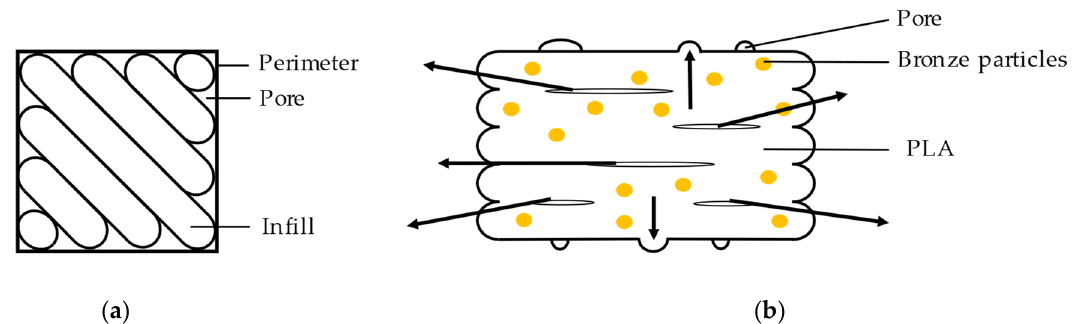
Figure 10. Illustration and scanning electron microscope (SEM) images of printed green tensile spec- imens (The red circles showed pores/gaps on the surfaces or inside of the specimens). ( a1 ) Illustra- tion of flat printed specimen; ( a2 ) top view of the flat specimen; ( a3 ) cross section of the flat speci- men; ( a4 ) zoomed view of cross section of the flat specimen; ( b1 ) illustration of on-edge printed specimen; ( b2 ) top view of the on-edge specimen; ( b3 ) cross section of the on-edge specimen; ( b4 ) zoomed view of cross section of the on-edge specimen; ( c1 ) illustration of upright printed specimen; ( c2 ) top view of the upright specimen; ( c3 ) cross section of the upright specimen; ( c4 ) zoomed view of cross section of the upright specimen.